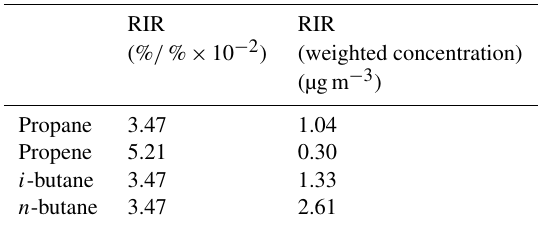
Figure 12. (a) O 3 –VOCs–NO x sensitivity within the cutting range of 0–60% of NO x . The black curve demonstrates the most sen- sitive response of O 3 to VOCs and NO x . Points A and B represent the O 3 –VOCs–NO x relationship before and during the program, re- spectively. The red and green curves in the small legend show the O 3 production as a function of VOC cuts before and during the pro- gram, respectively. (b) O 3 –VOCs–NO x sensitivity within the cut- ting range of 60–99.5% of NO x. Table 9. RIR and RIR (weighted concentration) of LPG-related VOCs.